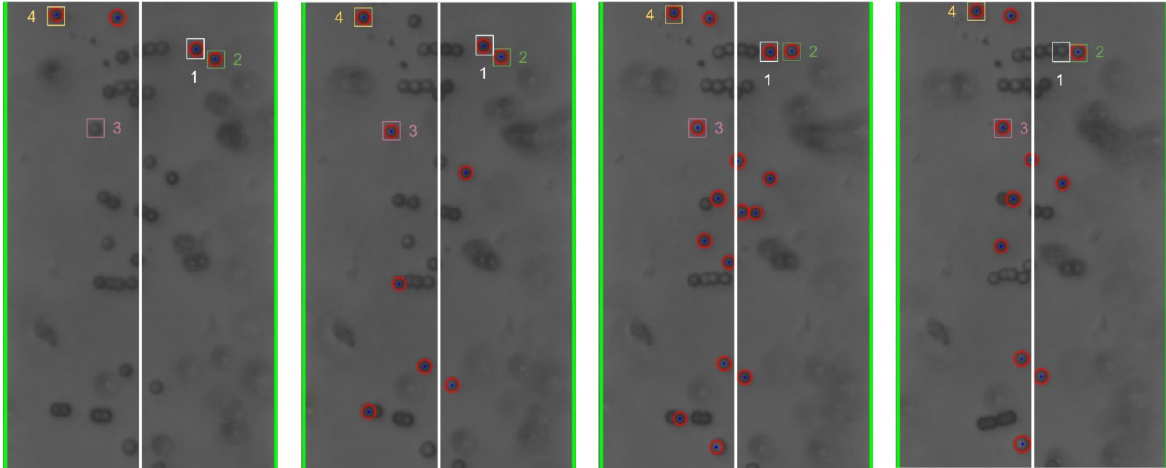
Figure 9. Individual bead movement during Trial 2 from frames 300 to 340. Figure 11. Individual bead movement during Trial 2 from frames 735 to 812. Figure 8. Individual bead movement during Trial 2 from frames 195 to 298.